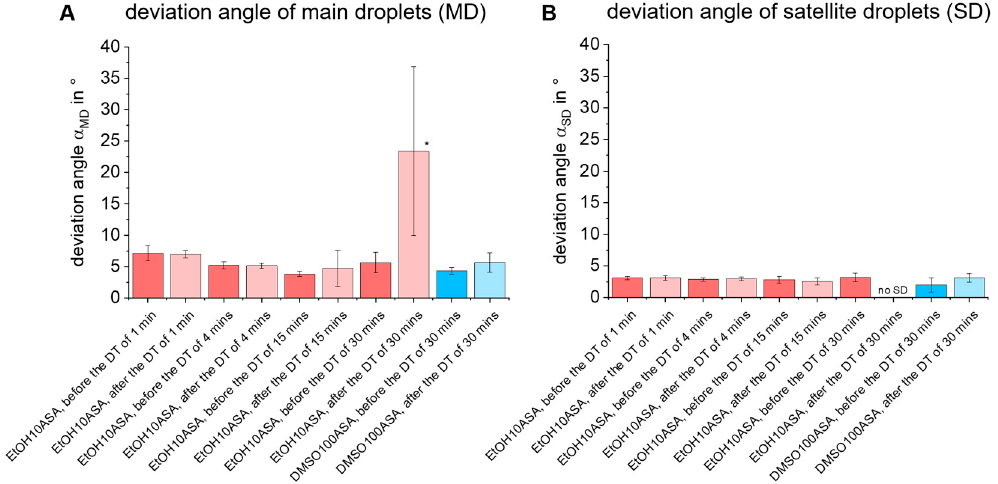
Figure 8. Plots of ( A ) deviation angle of main droplets ( α MD ) and ( B ) satellite droplets ( α SD ) of EtOH10ASA (c = 10 g/L ASA) and DMSO100ASA (c = 100 g/L ASA) before and the end of the dispensing tests (DT) with different time periods of t = 1 min, t = 4 min, t = 15 min and t = 30 min. 500 droplets of the drug solution EtOH10ASA were ejected uniformly over each of the four time periods. At a time period of t ≥ 15 min, droplet formation in EtOH10ASA is negatively affected by drug deposits on the printhead tip whereas the mean values of α MD do not change significantly. However, the reproducibility of α MD decreases, as indicated by an increase in the standard deviation. At a time period of t = 30 min, there is a significant increase in the mean value and standard deviation of α MD and no satellite droplets (“no SD”) were found (* the measurements were carried out at 2 out of 10 experimental replicates, termination of droplet formation occurred in 8 out of 10 experimental replicates). The deviation angle of the satellite droplets α SD was not negatively affected, but at a time period of t = 30 min, satellite droplet formation stopped during the dispensing test. For DMSO100ASA mean values and standard deviations of α MD and α SD did not change significantly. Droplet formation was not negatively affected because there were no drug deposits on the printhead tip even at the time period of t = 30 min despite the high drug concentration of c = 100 g/L. The plots show means ± standard deviations for n = 50.